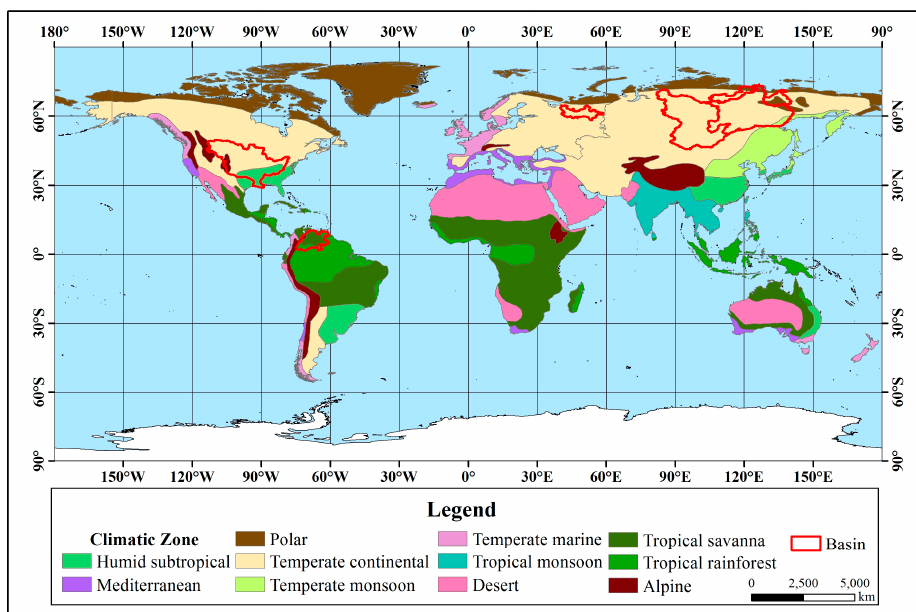
Figure 3. Distribution with a significant upward trend in river discharge.